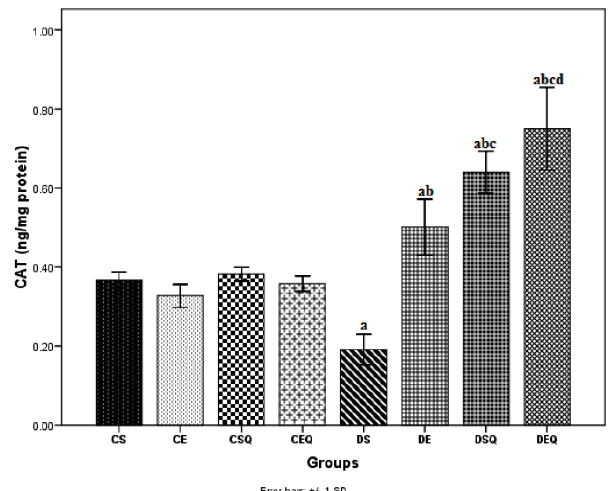
Figure 4. The effects of quercetin and moderate exercise training on the level of catalase (CAT) (ng/mg protein) activity in the thoracic aortic tissue homogenates of control and diabetic rats. Results are the means ± SD for ten animals each group, defined as in the caption of Figure 1. Statistically significant differences are indicated by the symbols: a p < 0.05 vs. CS group, b p < 0.05 vs. DS group, c p < 0.05 vs. DE group and d p < 0.05 vs. DSQ group.